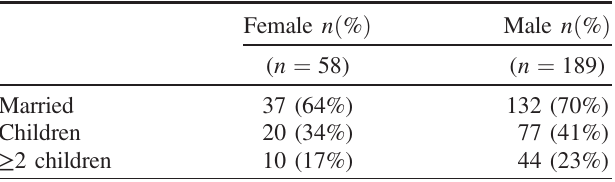
TABLE VI. Family status of survey